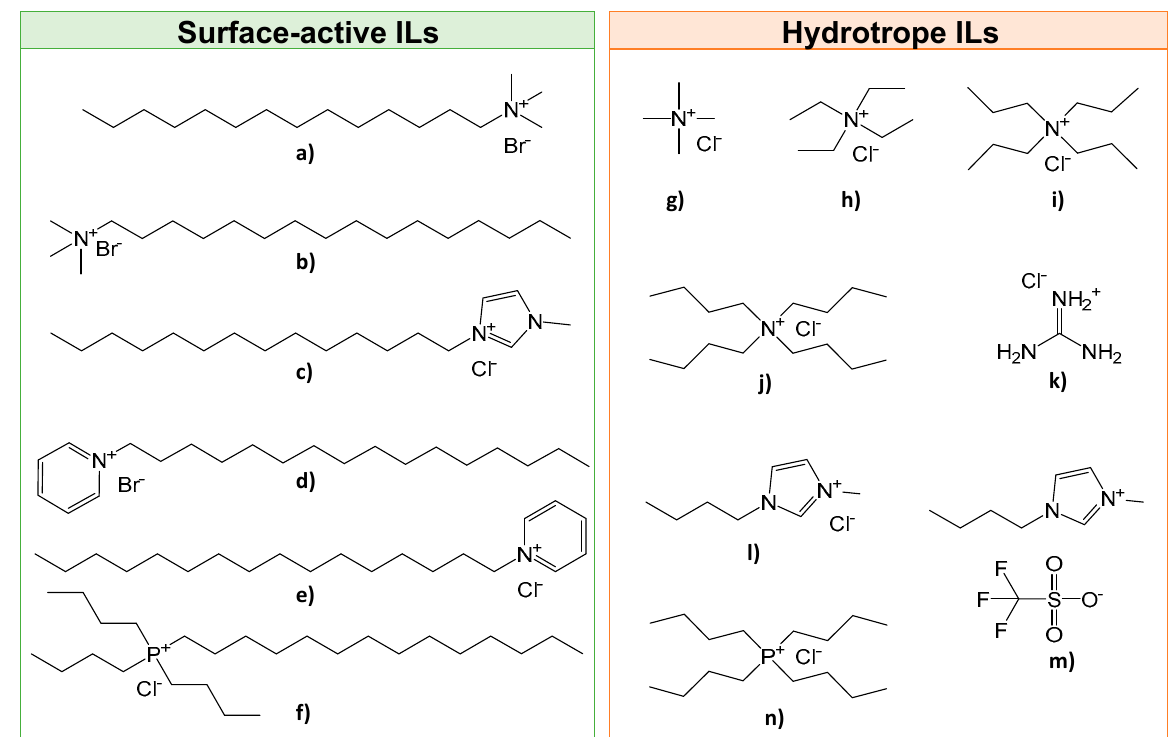
Figure 2. Chemical structures of the ILs investigated: ( a ) [N 11114 ]Br; ( b ) [N 16111 ]Br; ( c ) [C 14 mim]Cl; ( d ) [C 16 py]Br; ( e ) [C 16 py]Cl; ( f ) [P 44414 ]Cl; ( g ) [N 1111 ]Cl; ( h ) [N 2222 ]Cl; ( i ) [N 3333 ]Cl; ( j ) [N 4444 ]Cl; ( k ) [Gdm]Cl; ( l ) [C 4 mim]Cl; ( m ) [C 4 mim][CF 3 SO 3 ]; and ( n ) [P 4444